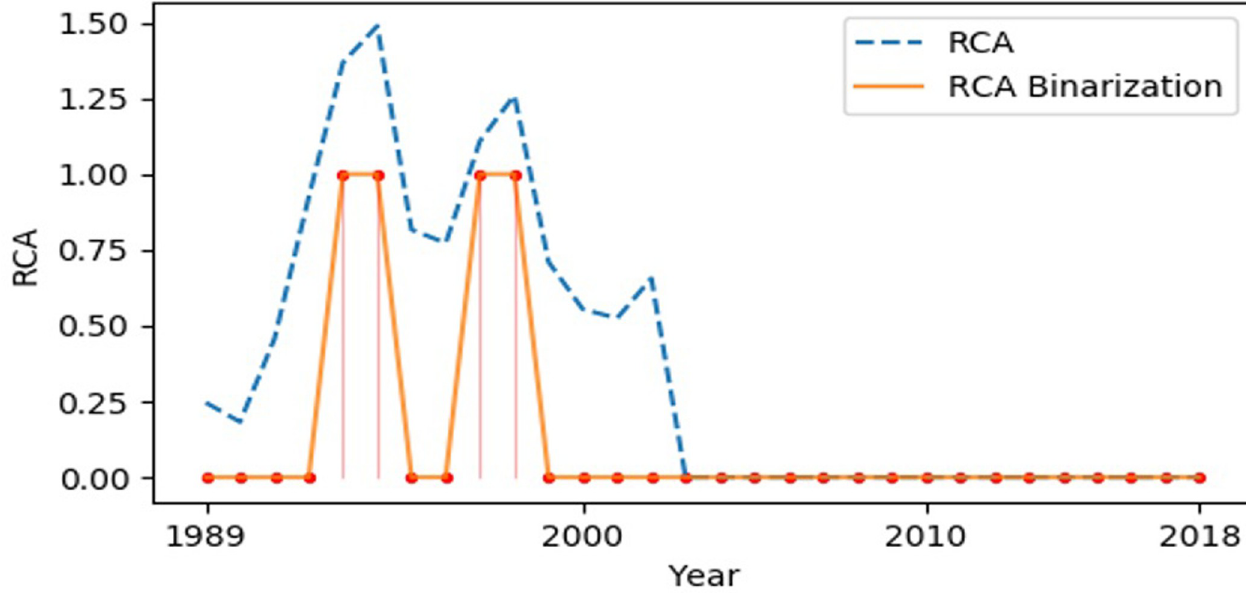
Fig 3. RCA raw data (RCA) and RCA binarization data (RCA Binarization). The data analysis is performed by comparing the RCA raw data (RCA) and RCA binary noise reduction data (RCA Binarization), in which the dotted line is the original RCA data and the solid line is the RCA binary noise reduction